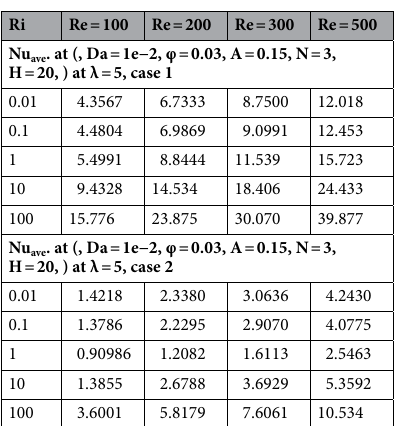
Nu ave . at (, Da = 1e−2, φ = 0.03, A = 0.15, N = 3, H = 20, ) at λ = 5, case 2